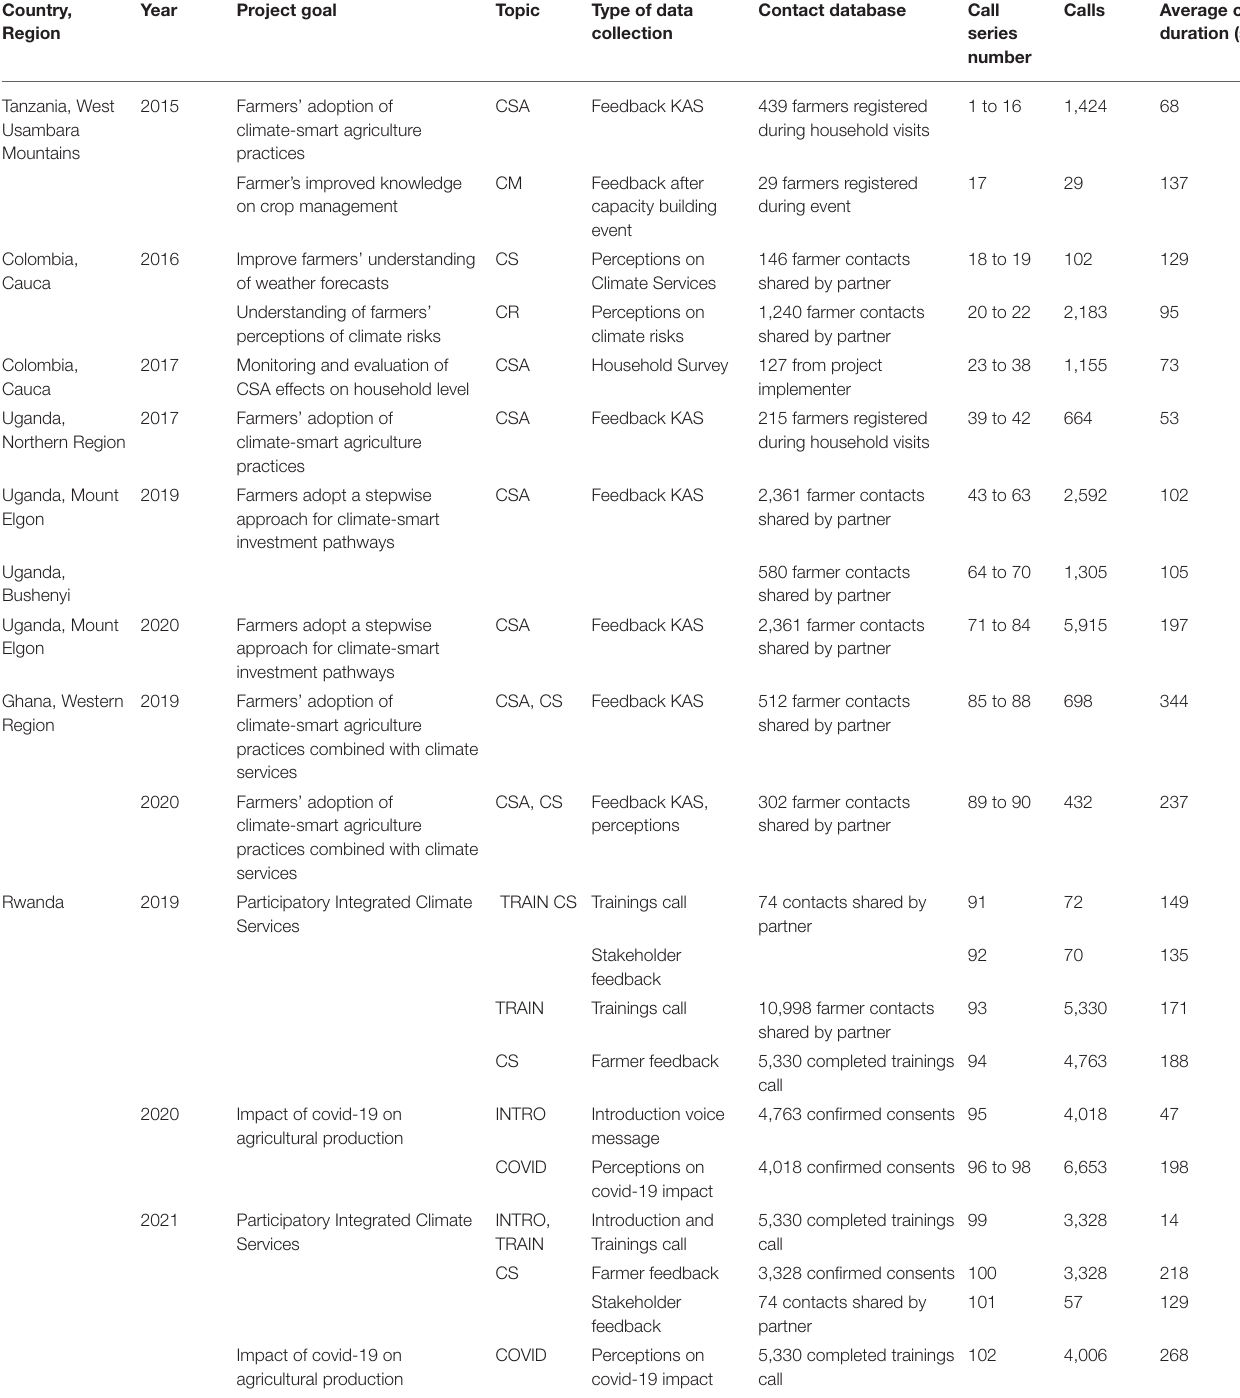
TABLE 1 | Projects using 5Q combined with IVR survey campaigns. Country,